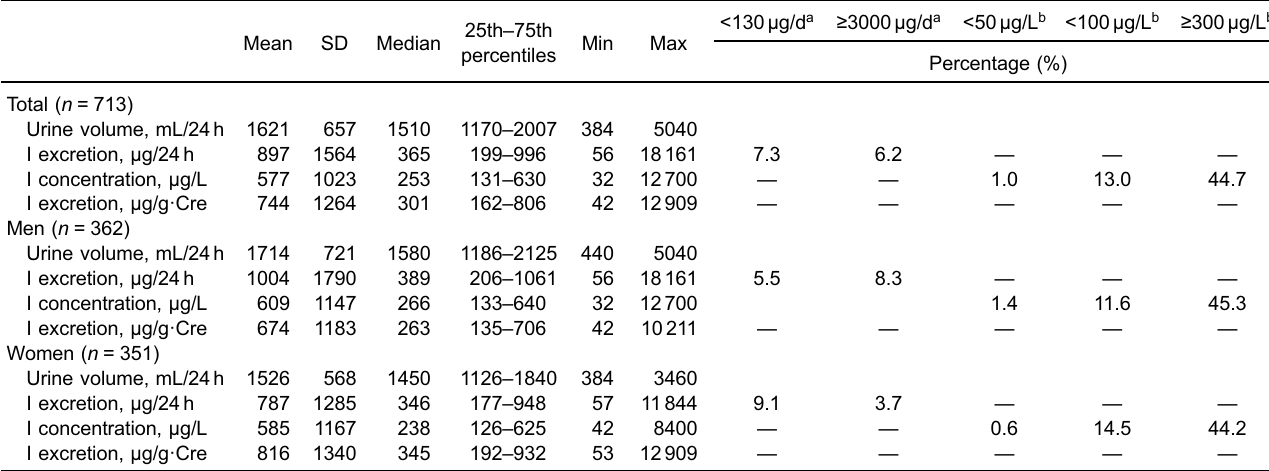
Table 2. Iodine excretion in 24-hour urine and iodine concentration (µg/L and µg/g·Cre) in 713 Japanese adults Mean